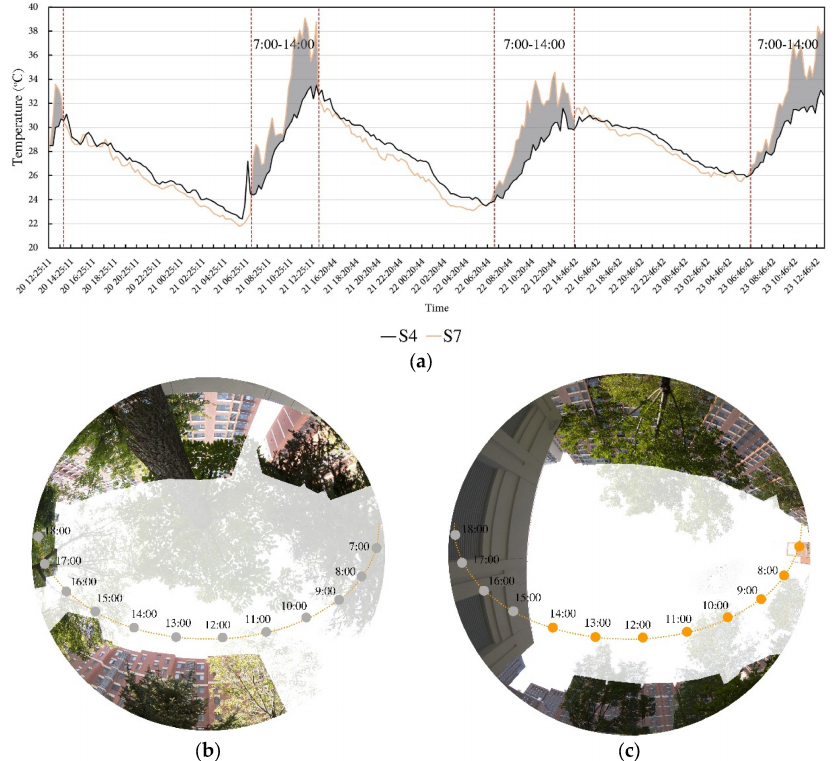
Figure 13. Ta changes ( a ) at 20–23 August and fisheye photos ( b , c ) of S4, S7 in Shuangqing Estate.